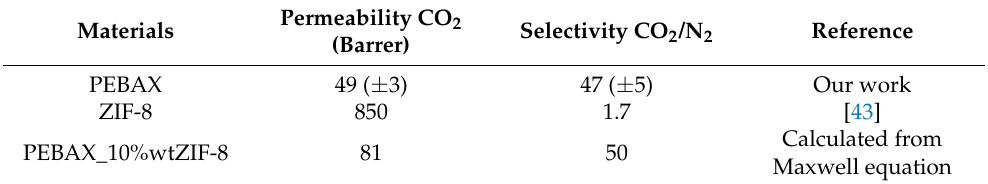
Table 1. Predicted CO 2 permeability and CO 2 /N 2 selectivity (ZIF-8 density = 0.95 g/cm 3